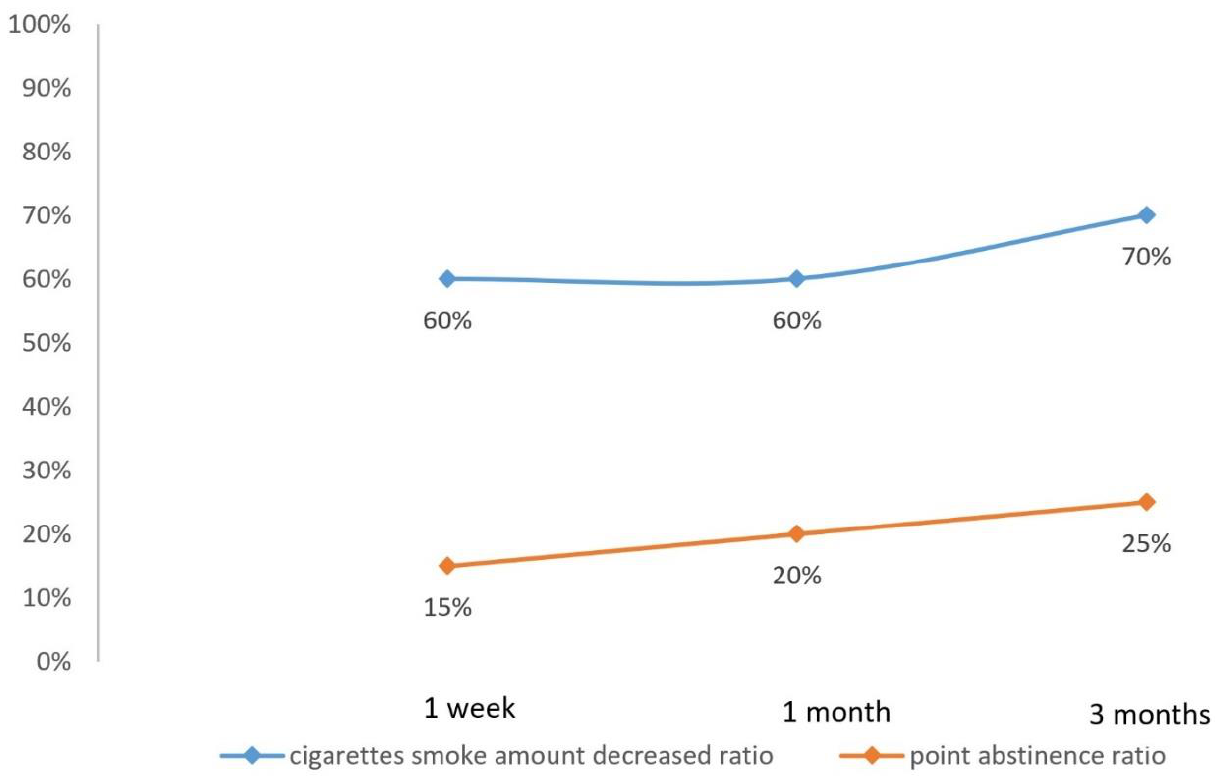
Figure 2. Cigarette smoke amount decreased ratio and point abstinence ratio.